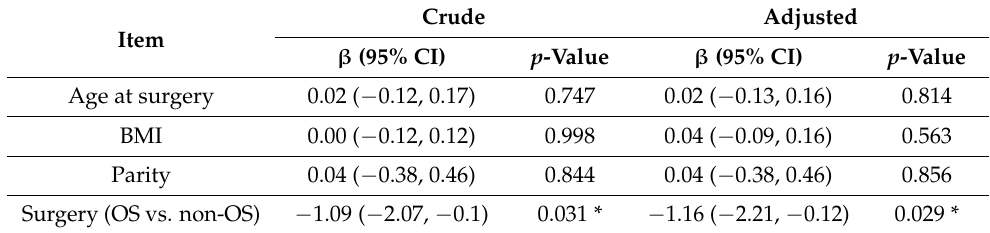
Table 5. Factors associated with surgery to menopause